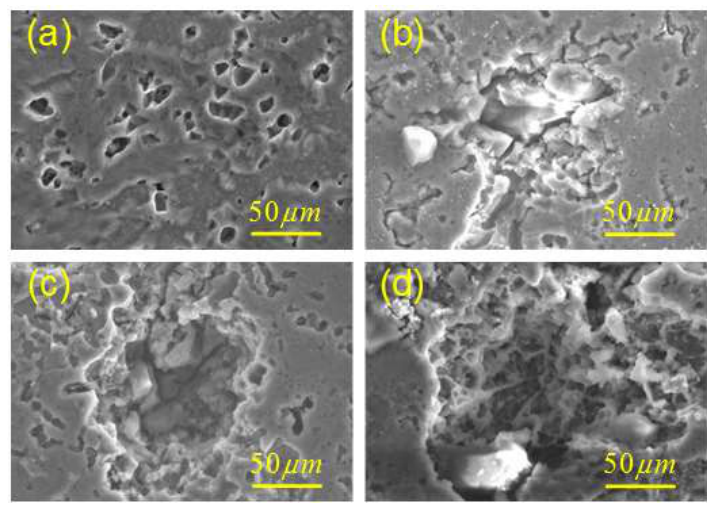
Figure 2. Corrosion morphology of aluminum alloy 2024-T4 exposed to EXCO solution for different times ( a ) 0 h, ( b ) 24 h, ( c ) 48 h, ( d ) 96 h.